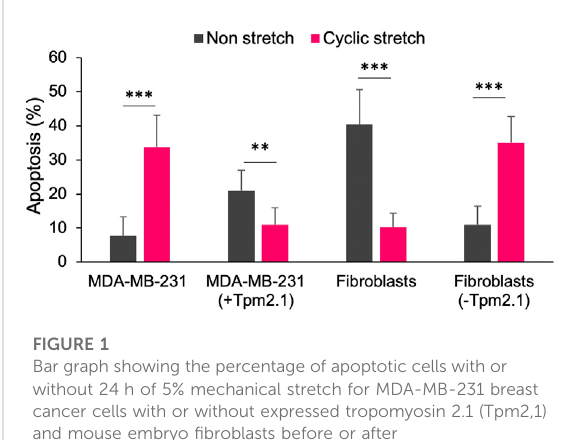
FIGURE 1 Bar graph showing the percentage of apoptotic cells with or without 24 h of 5% mechanical stretch for MDA-MB-231 breast cancer cells with or without expressed tropomyosin 2.1 (Tpm2,1) and mouse embryo fi broblasts before or after Tpm2.1 knockdown. Adapted from (Tijore et al.,